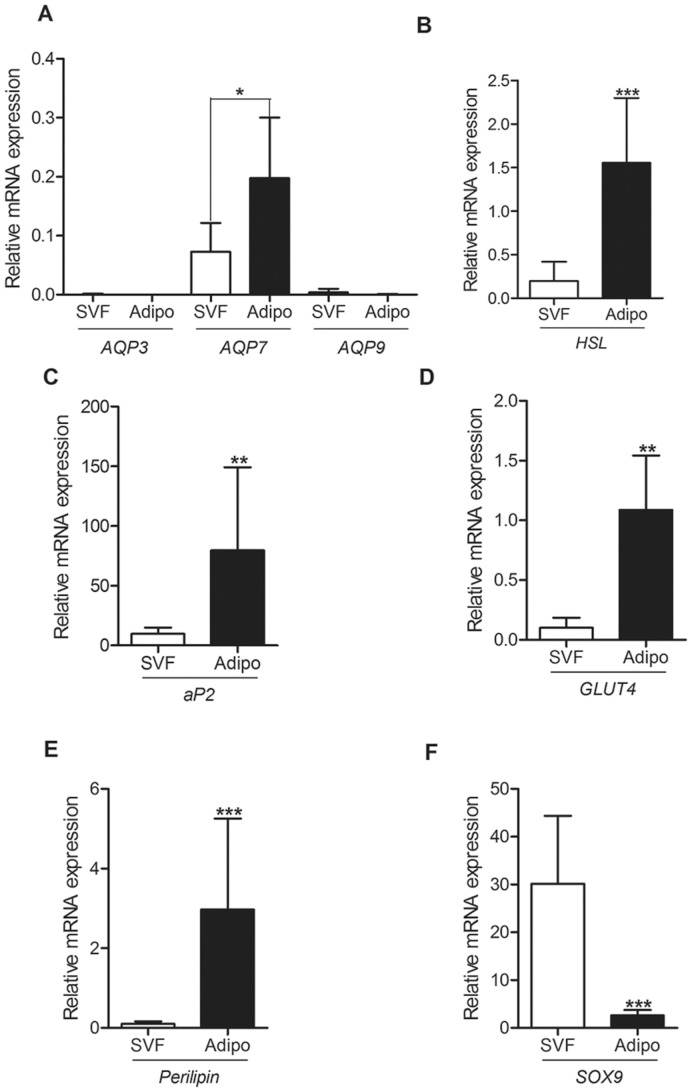

AQP7 expression is higher in isolated mice adipocytes than in the stromal vascular fraction (SVF) of adipose tissue.A- AQP3, AQP7 and AQP9 mRNA expression in isolated mice adipocytes (black bars) and SVF (white bars). B–F - mRNA levels of specific markers of mature adipocytes (aP2, GLUT4, HSL and Perilipin) and of the capillary endothelia of adipose tissue (SOX9). eEF2 (eukaryotic translation elongation factor 2) mRNA levels were used as reference genes. Data represent mean ± SD derived from five independent experiments. Statistically significant differences detected by Student's t are indicated by ** P<0.01; *** P<0.001.